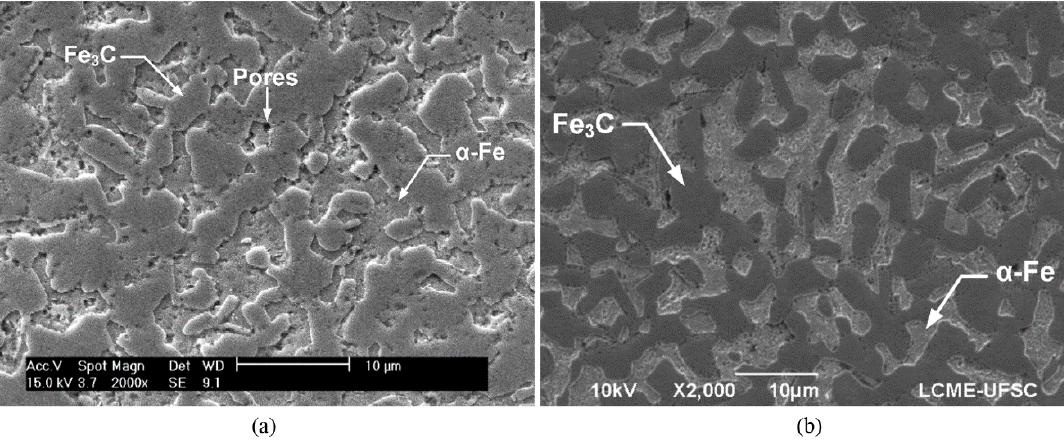
and (b) 20% CH 4 4